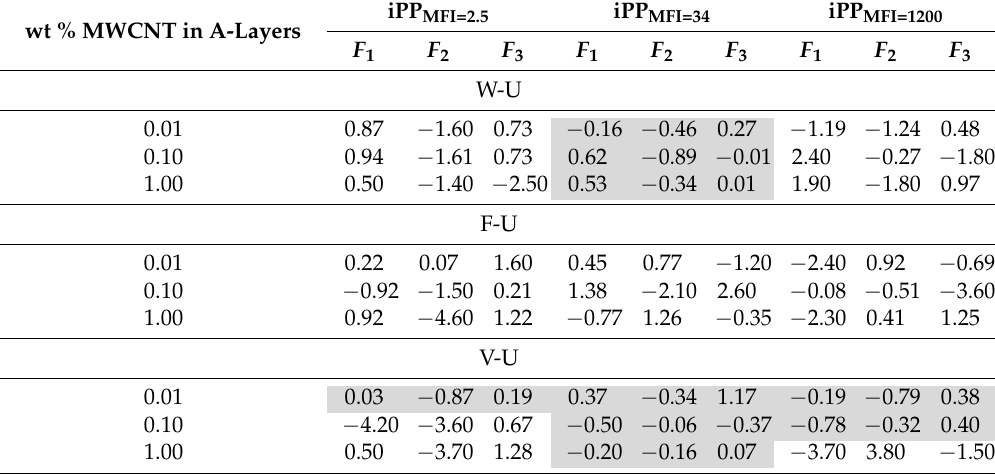
Table 3. Electrostatic charge (kV) for unstuck ABA films fabricated using masterbatches with MFI = 2.5, 34 and 1200 g/10 min. The masterbatches were fabricated using ultrasound-assist methods: W-U, F-U and V-U.